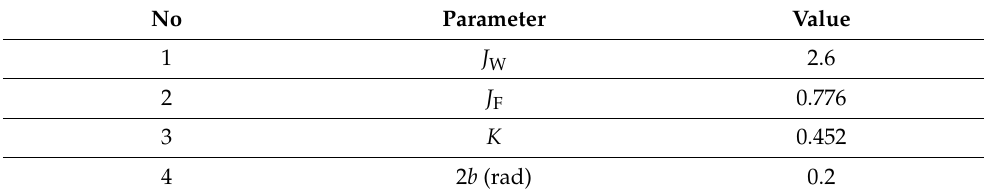
Figure 5. The Bode diagram of the two-mass wind turbine drivetrain. ( a ) Wind turbine transfer function Bode diagram; ( b ) Generator transfer function Bode diagram. Table 1. The simulation experiment parameters in per unit based on high speed